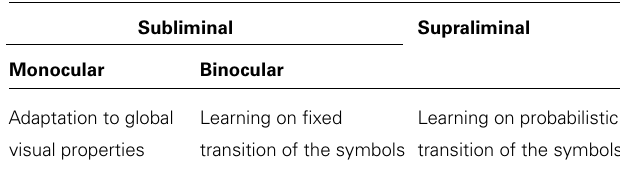
Table 2 |Three types of learning process suggested by our experiments.